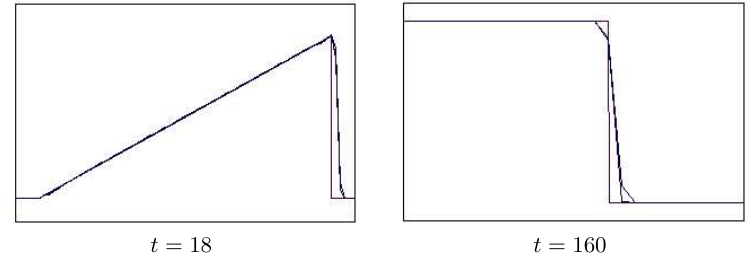
Figure 13. Numerical solution for the Babenko scheme for 2 initial data ( (cid:13) = 0 : 1; 0 : 5; 0 : 9 ).